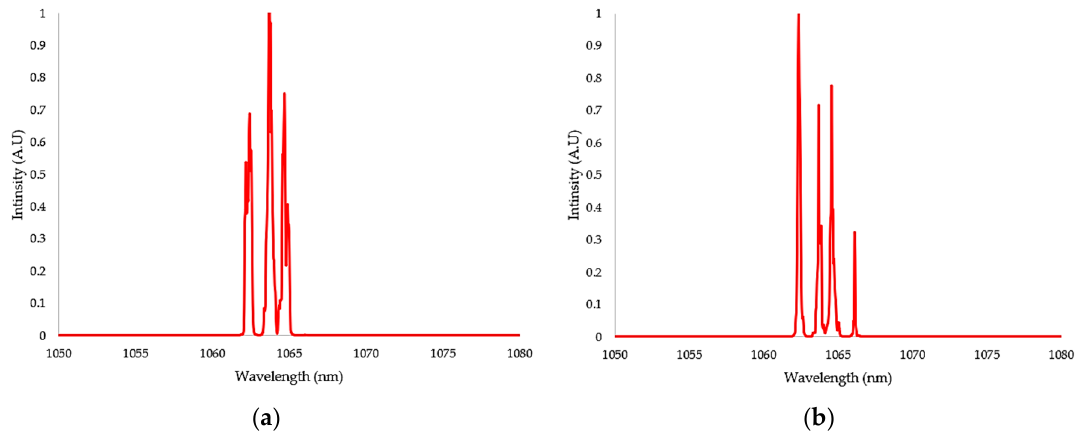
Figure 11 . The measured output spectrum of ( a ) tri-wavelength emission at 1062.4 nm, Figure 11. The measured output spectrum of ( a ) tri-wavelength emission at 1062.4 nm, 1063.6 nm, and 1063.6 nm, and 1064.6 nm, and ( b ) quad-wavelength emission at 1062.3 nm, 1063.6 nm, 1064.6 nm, and ( b ) quad-wavelength emission at 1062.3 nm, 1063.6 nm, 1064.5 nm, and 1066.1 1064.5 nm, and 1066.1 nm.